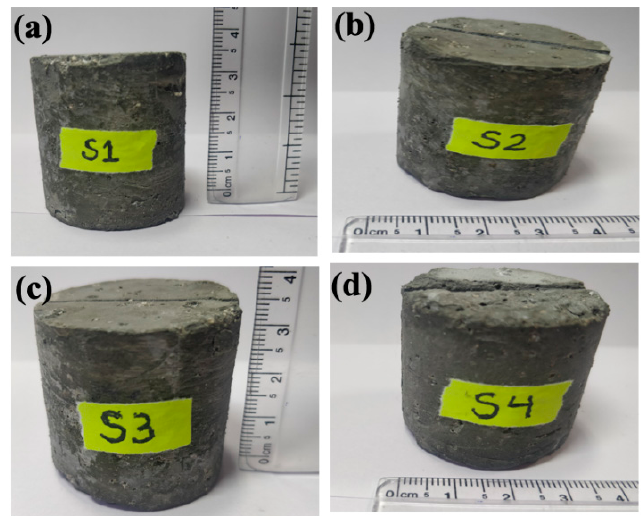
Figure 2. Snapshots of the synthesized cement core with ( a ) 4% ( b ) 8% ( c ) 12% and ( d ) 16% dosage of DPAM.